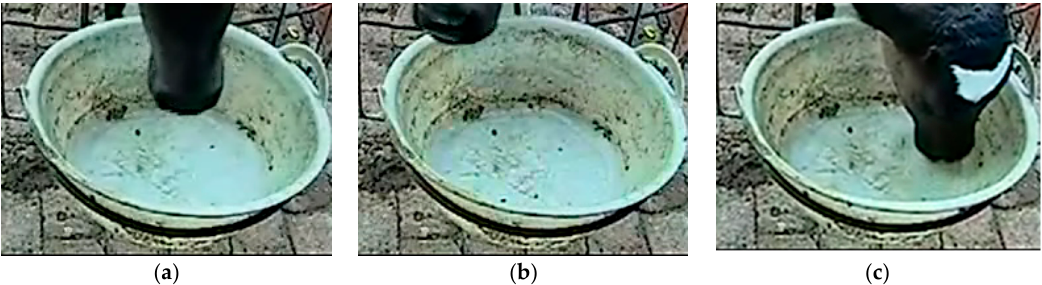
Figure 9. Target behavior in drinking area. ( a ) Preparing for drinking; ( b ) Looking around; ( c ) Drinking. In total, 1080 frames were sampled in the feeding area and 2045 frames in the drinking area.